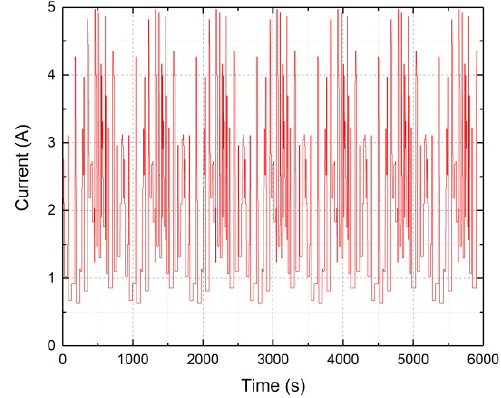
Figure 7. Current profile.